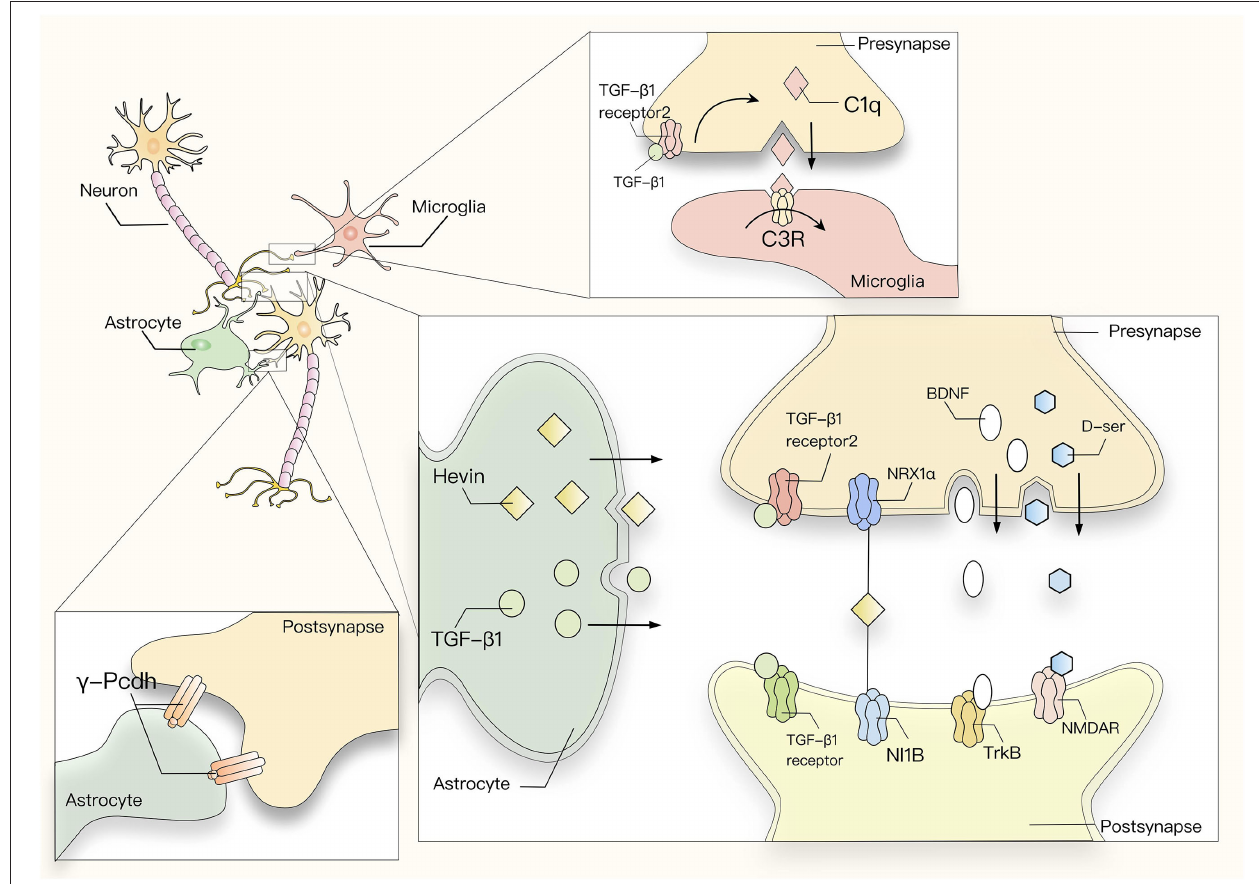
FIGURE 2 | Astrocytic cytokines and neurotransmitters participate in the regulation of synaptic plasticity. TGF- β 1 secreted by astrocytes induces the formation of inhibitory synapses by activating neuronal calcium/calmodulin dependent protein kinase II (CaMK II), or promotes the formation of excitatory synapses through an activity-dependent mechanism of the NMDA receptor together with its agonist D-ser. In addition, the development of both excitatory and inhibitory synapses is affected by astrocyte-neuron adhesion mediated by astrocytic γ -Pcdh. Astrocytes secrete Hevin to interact with two proteins, presynaptic NRX1 α and postsynaptic NL1b, which usually do not interact with each other, thus promoting synapse formation. On the other hand, BDNF regulates LTP mainly by binding to the TrkB receptor. Astrocytes can also induce the production of complement protein C1q by secreting TGF- β and thereby acting on TGFBR2 in the synapse. C1q is recognized by microglia and triggers C3R-mediated